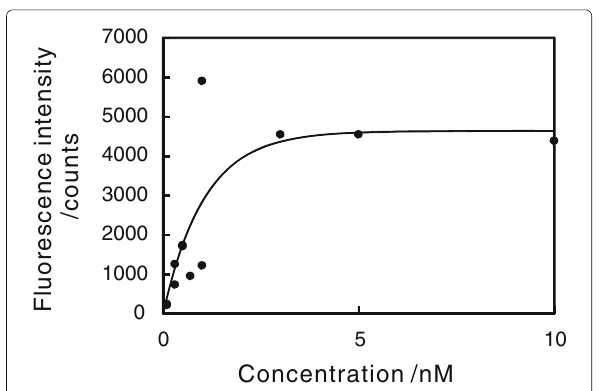
Fig. 2 Fluorescence intensity as a function of the concentration of QD solution